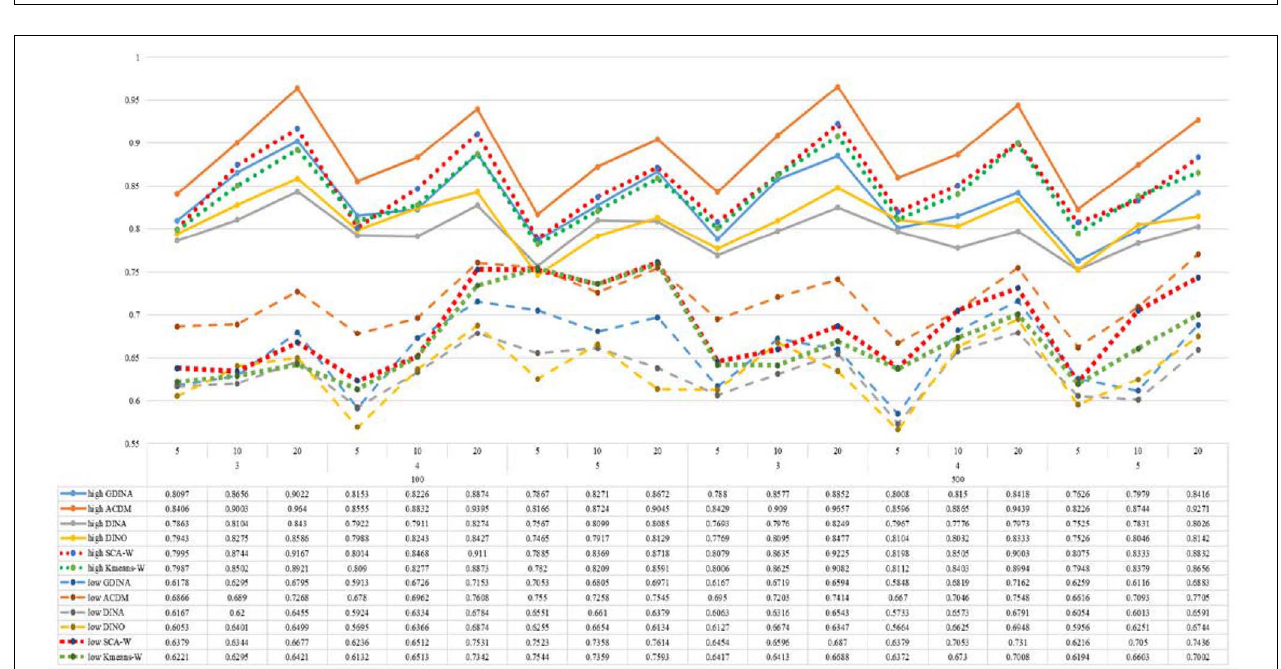
FIGURE 3 | Mean values of ARI by SCA, K-means, and fitted models; True model = A -CDM.